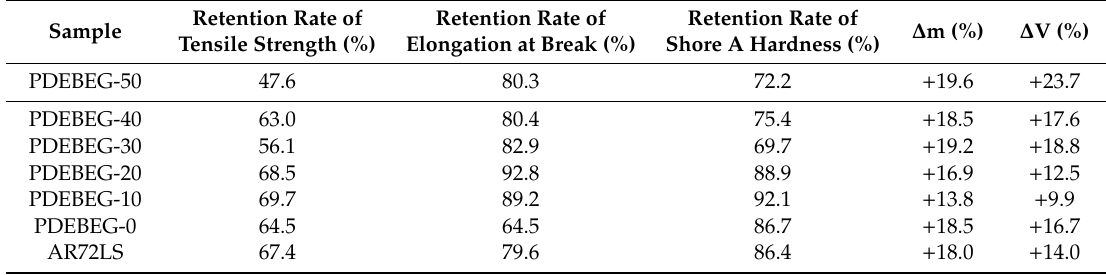
Table 7. Retention of mechanical properties of PDEBEG / CB and AR72LS / CB vulcanizates before and after soaking in ASTM 3# oil at 150 ◦ C for 72